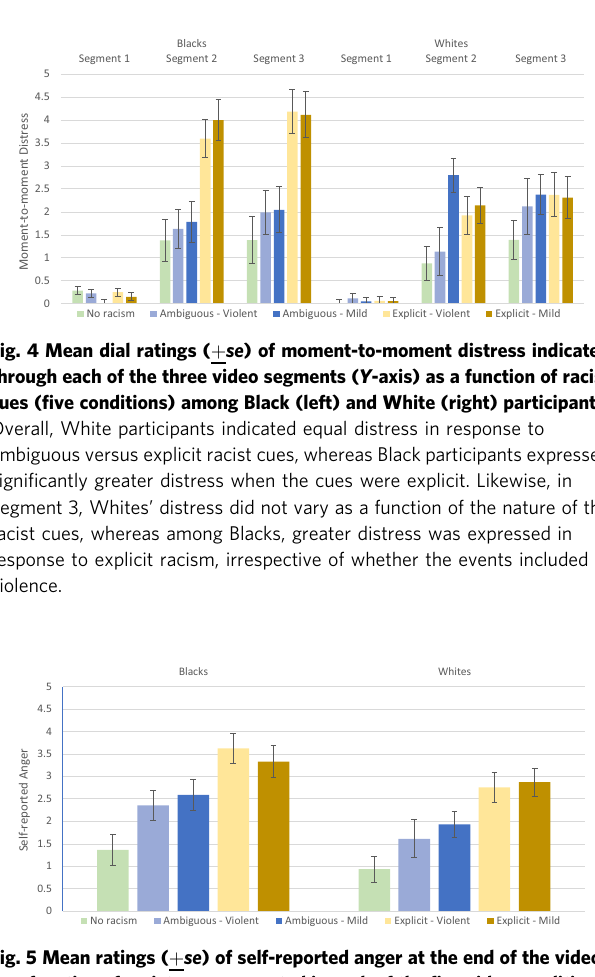
main effect of racist cues, F (4,200) = 13.38, p < 0.001, η 2 = 0.211, which was not moderated by ethnoracial group, F < 1. As seen in Fig. 5, the presence of racist cues elicited greater anger, t (205) = 5.97, p < 0.001, particularly in response to explicit (relative to ambiguous) racism, t (205) = 4.12, p < 0.001, irrespec- tive of whether the events were mild or violent.